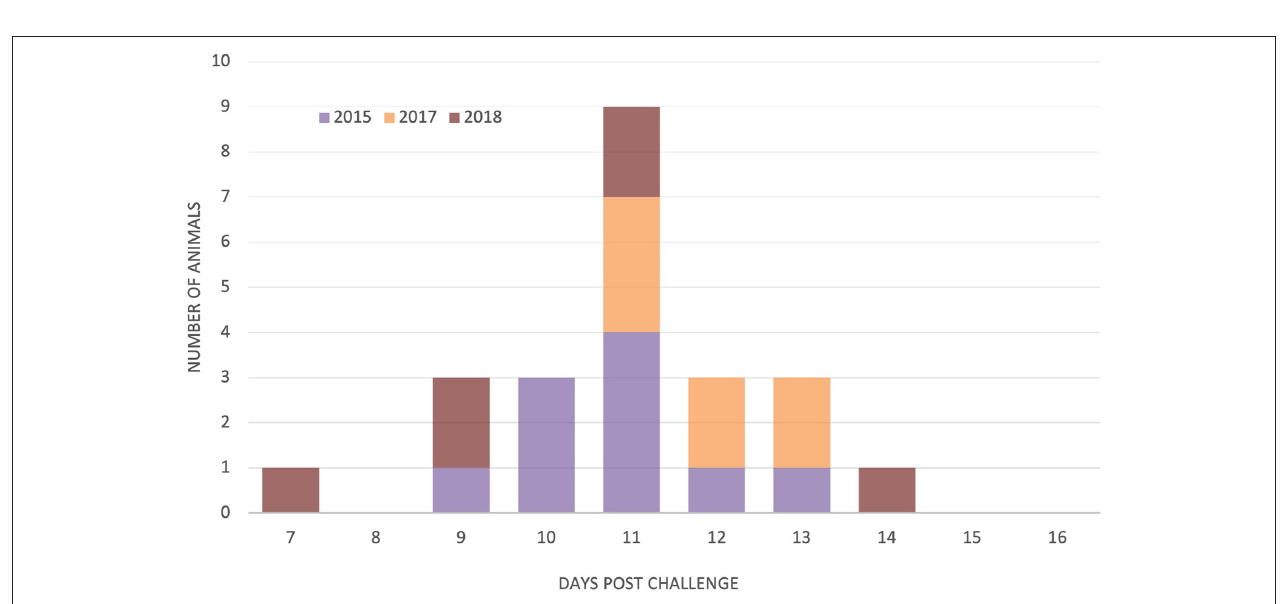
FIGURE 3 | Day of detection of parasitosis in parotid and/or pre-scapular lymph nodes in study animals from three trials N = 10 (2015), 7 (2017), and 6 (2018).